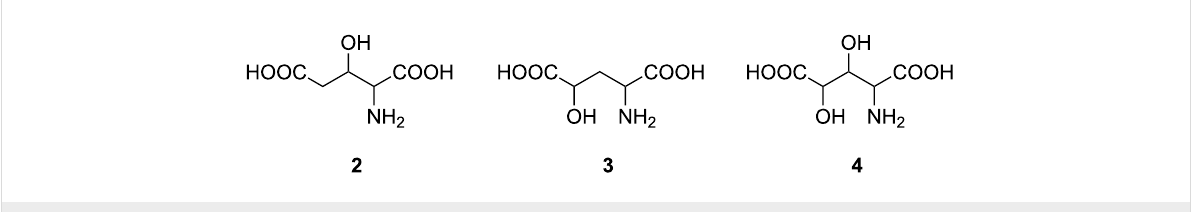
Figure 2: 3-Hydroxy- ( 2 ), 4-hydroxy- ( 3 ) and 3,4-dihydroxyglutamic acids ( 4 ).